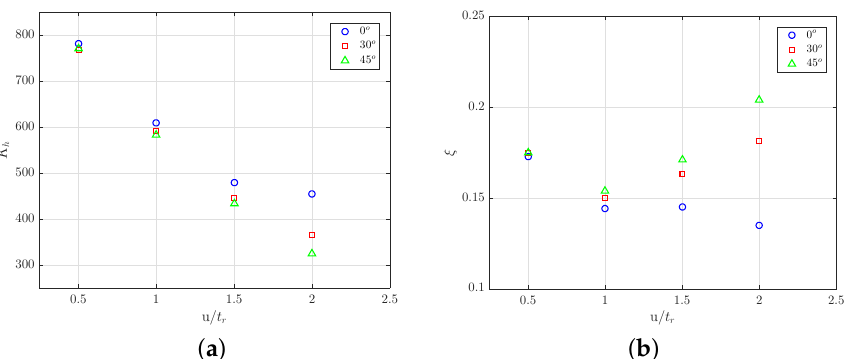
Figure 23. ( a ) Effective horizontal stiffness, k h , and ( b ) equivalent damping ratio, ξ , under different reinforcement orientations.